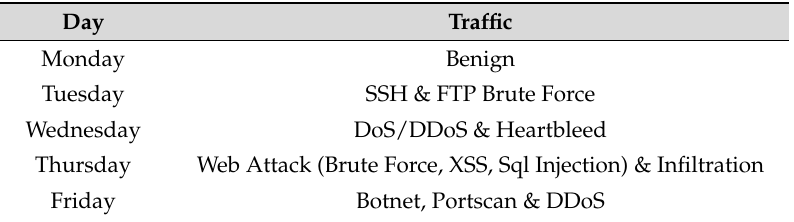
Table 1. CICIDS2017